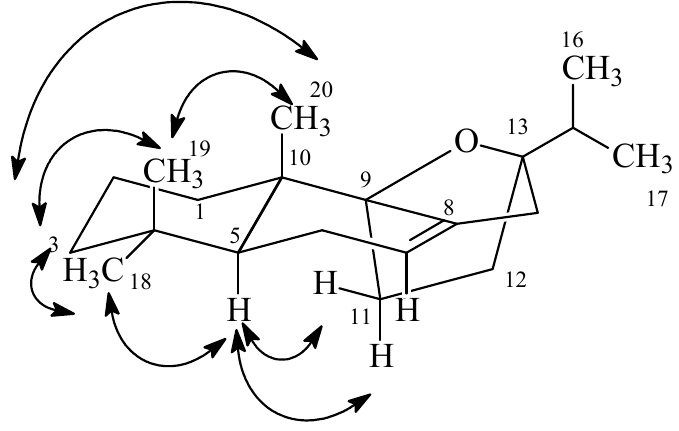
Figure 1. COSY( ▬ ) and selected HMBC (H → C) correlations of 1